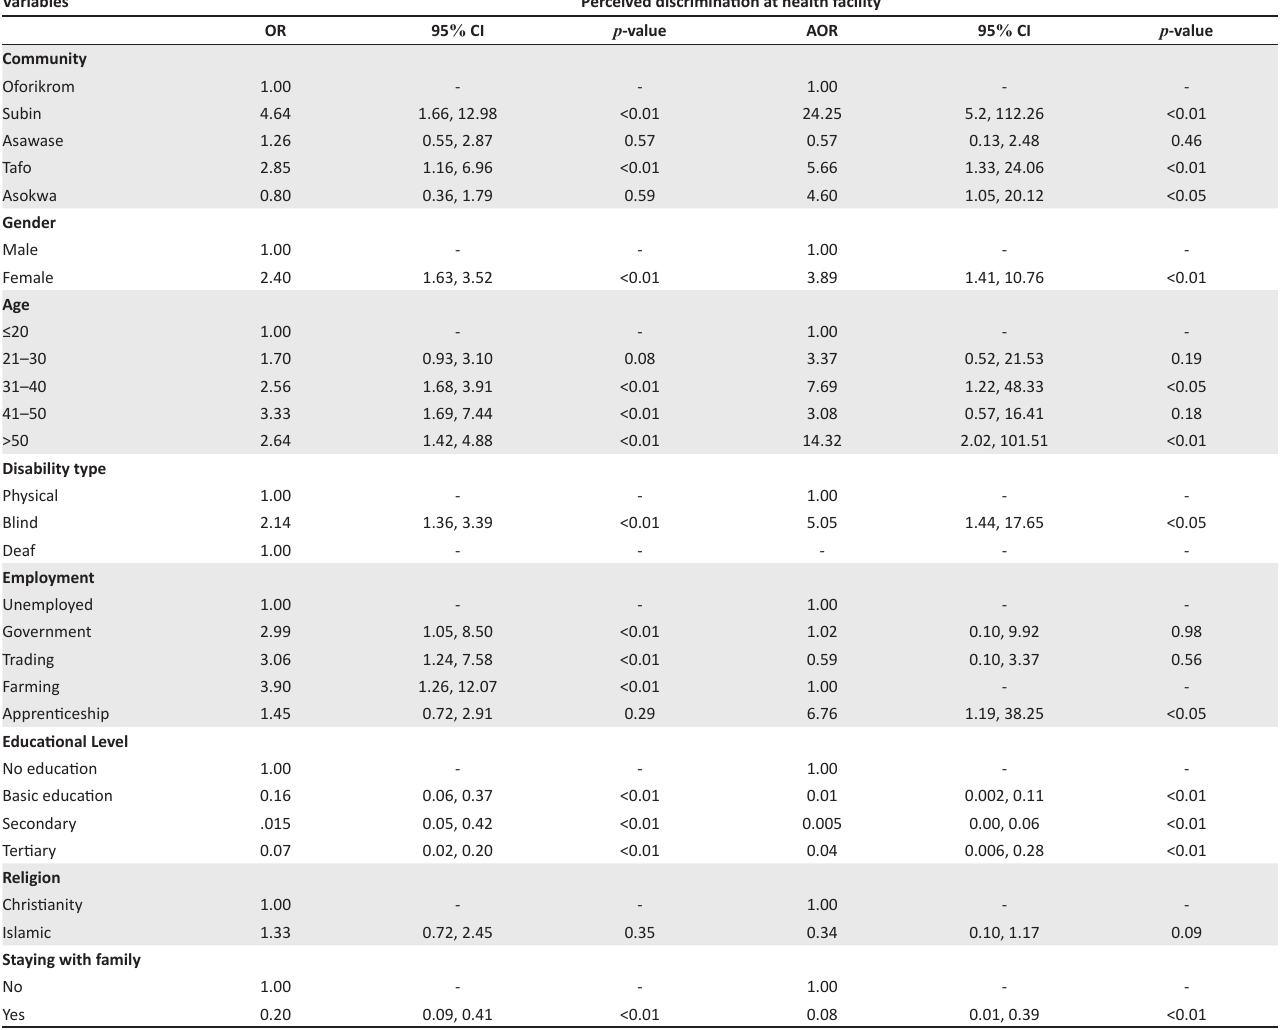
TABLE 3: Logistic regression analysis of socio-demographic factors on perceived discrimination against people with disabilities.